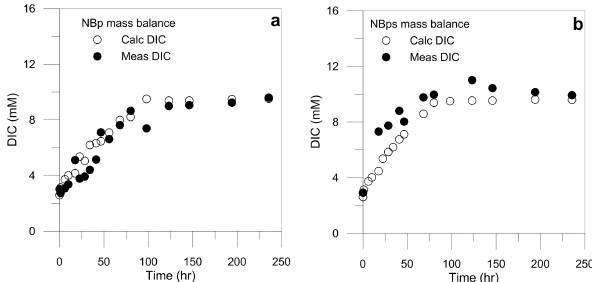
Fig. 3. Calculated ( (cid:13) ) and measured ( • ) values of DIC for treat- ments NBp (a) and NBps (b)